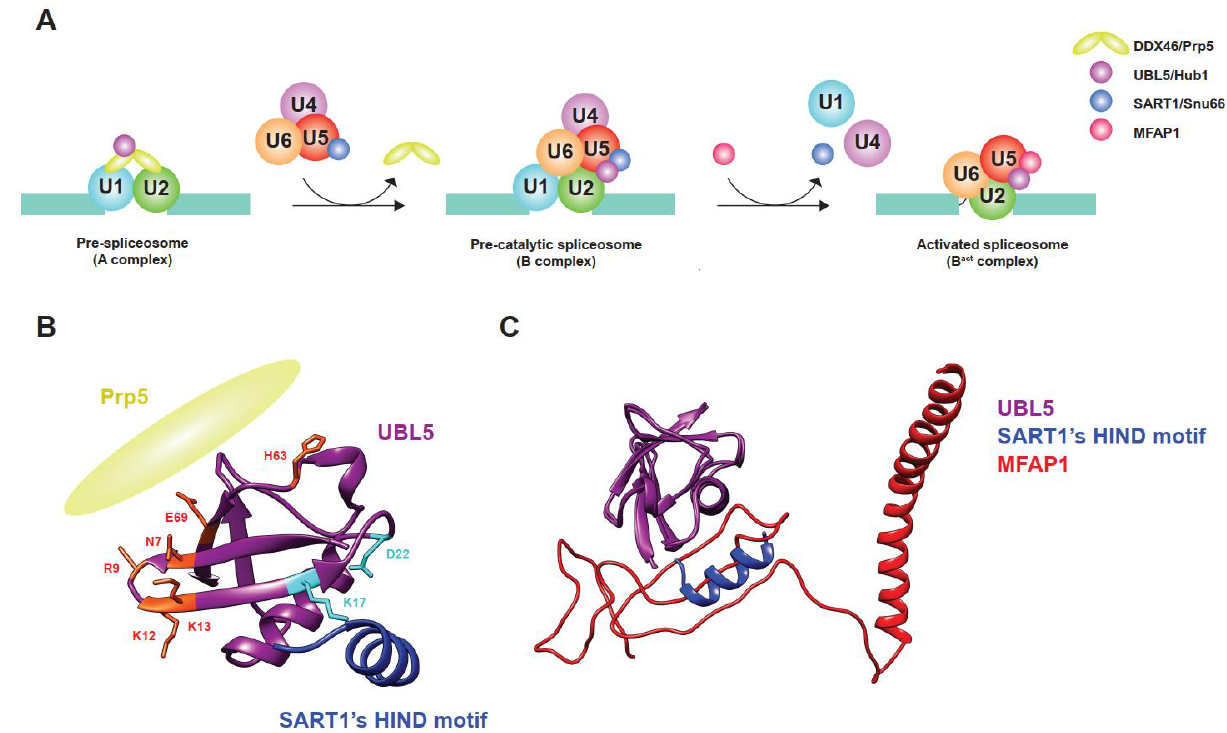
Figure 2. Sequential and differential interaction of UBL5/Hub1 during assembly and activation of the spliceosome. ( A ) Schematic depiction of events in which UBL5/Hub1 functions during assembly and activation of the spliceosome. U1 and U2 snRNPs recognize an intron of pre-mRNA and form a pre-spliceosome (A complex). UBL5/Hub1 binds to the RNA helicase DDX46/Prp5 bridging the two snRNPs. After release of the helicase, the ubiquitin relative binds to SART1/Snu66, a component of U4/U6.U5 tri-snRNP that is recruited during the formation of a pre-catalytic spliceosome (B complex). Subsequent recruitment, release, and rearrangement of proteins and snRNAs lead to formation of an activated spliceosome (B act complex). During the activation, MFAP1/Spp381 replaces SART1/Snu66 and interacts with UBL5/Hub1. ( B ) Ribbon diagram that shows two functional surfaces of UBL5/Hub1 (purple). Amino acid residues that are important for interaction with DDX46/Prp5 (yellow) and HIND motif of SART1/SNU66 (blue) are labeled in red and light blue, respectively. ( C ) MFAP1/Spp381 and SART1/Snu66 share the same surface of UBL5/Hub1 for interaction. Superimposition of human UBL5 structures in the pre-catalytic (PDB: 6AHD) and activated (PDB: 7ABG) spliceosomes show the mutually exclusive interaction of MFAP1 (red) and HIND motif of SART1 (blue) with UBL5 (purple).